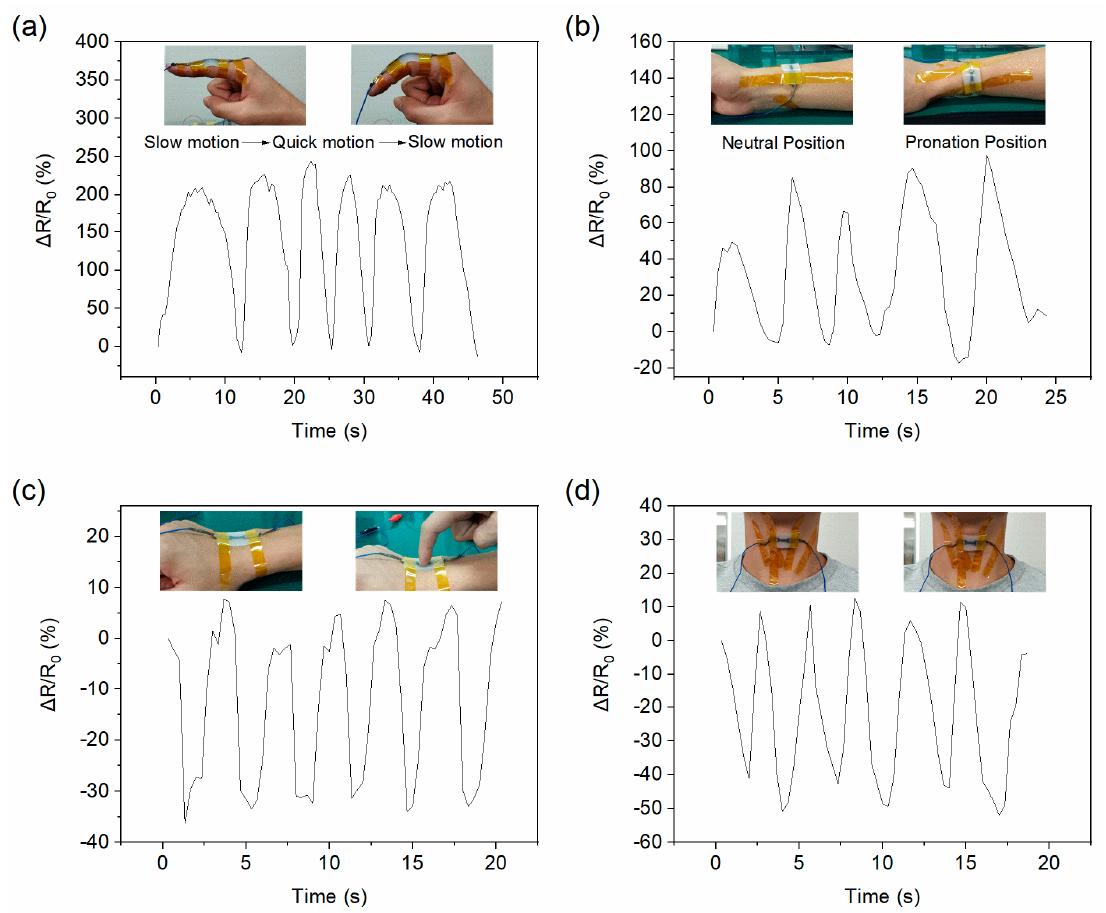
Figure 6. Human body movement detection using the G / GL based sensor; ( a ) finger movement, ( b ) wrist rotation, ( c ) “clicking” the sensor, ( d ) drinking water (movement of Adam’s apple).